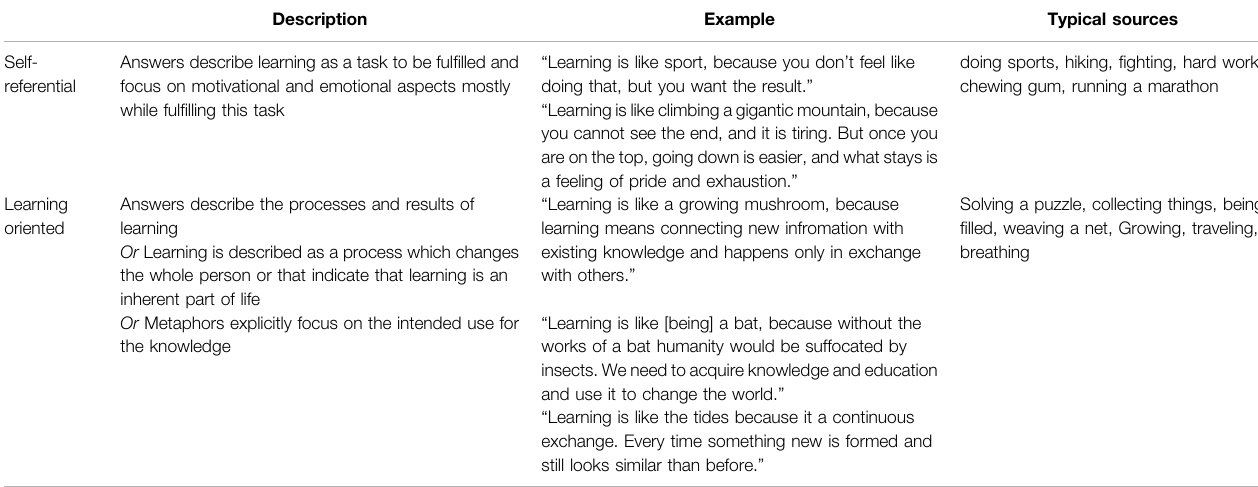
TABLE 3 | Overview over the categories used in the classi fi cation of